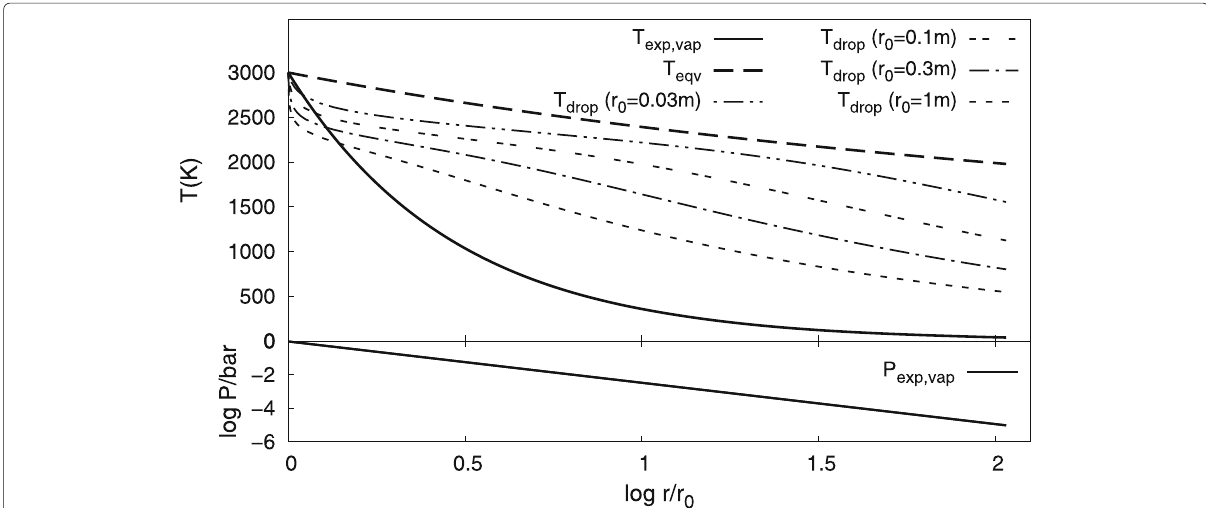
Fig. 10 Upper panel: Temperature profile of the expanding vapor (T exp,vap : solid line), and those of ejected jet-droplets (T drop ) with a constant product of aV e = 2 × 10 − 3 m 2 s − 1 , starting from 3000 K as functions of the normalized radius, r / r 0 . Four r 0 values (0.03, 0.1, 0.3, and 1 m) are selected for the radius of duston. The temperature profile of the expanding vapor is independent of the duston’s normalized radius. T eqv is the condensation temperature of a saturated silicate vapor whose pressure is equivalent to that of the expanding vapor, shown in the lower panel. Lower panel: Pressure profile of the adiabatically expanding vapor (P exp,vap ). T eqv is higher than the droplet temperatures, meaning that the expanding vapor is always supersaturated for the